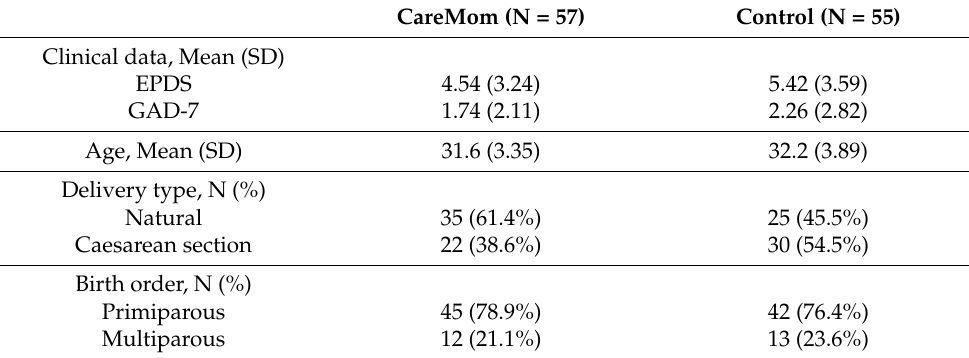
Table 2. Demographic and clinical data of participants at